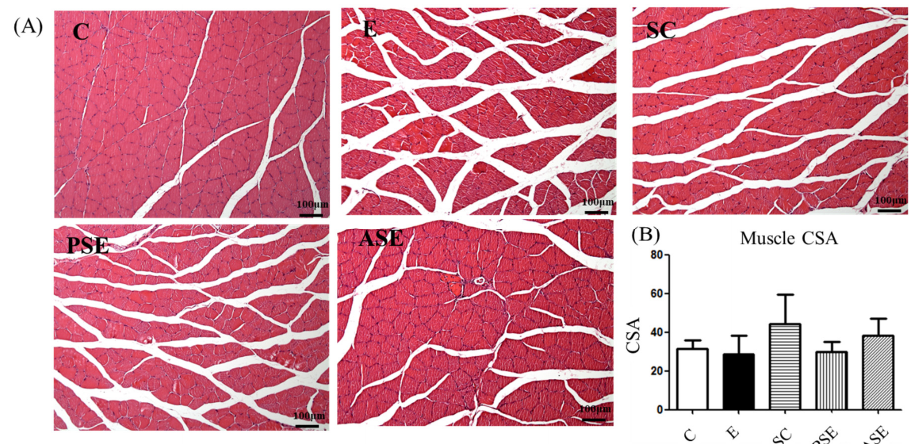
Commented [M8,2]: Please add the numbering for figure 8. ( A and B) in the picture.